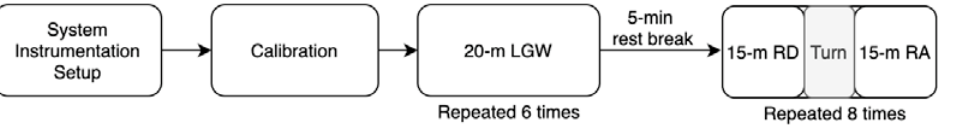
Figure 2. Experimental protocol overview for the data collection session. LGW: level-ground walking, RA: ramp ascent, RD: ramp descent.